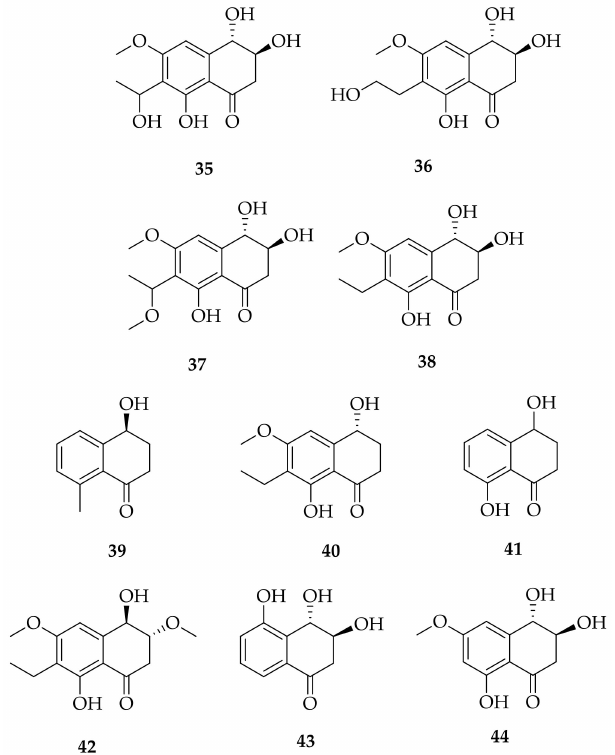
Figure 6. Structures of naphthalenones: botryosphaerones A–D, isosclerone, O -methylasparvenone, O -methylaspmenone, (3 R ,4 R )-3-methoxyl-botryosphaerone D, 3,4,5-trihydroxy-1-tetralone, (3 S ,4 S )- 3,4,8-trihydroxy-6-methoxy-3,4-dihydro-1(2H)-naphthalenone ( 35 – 44